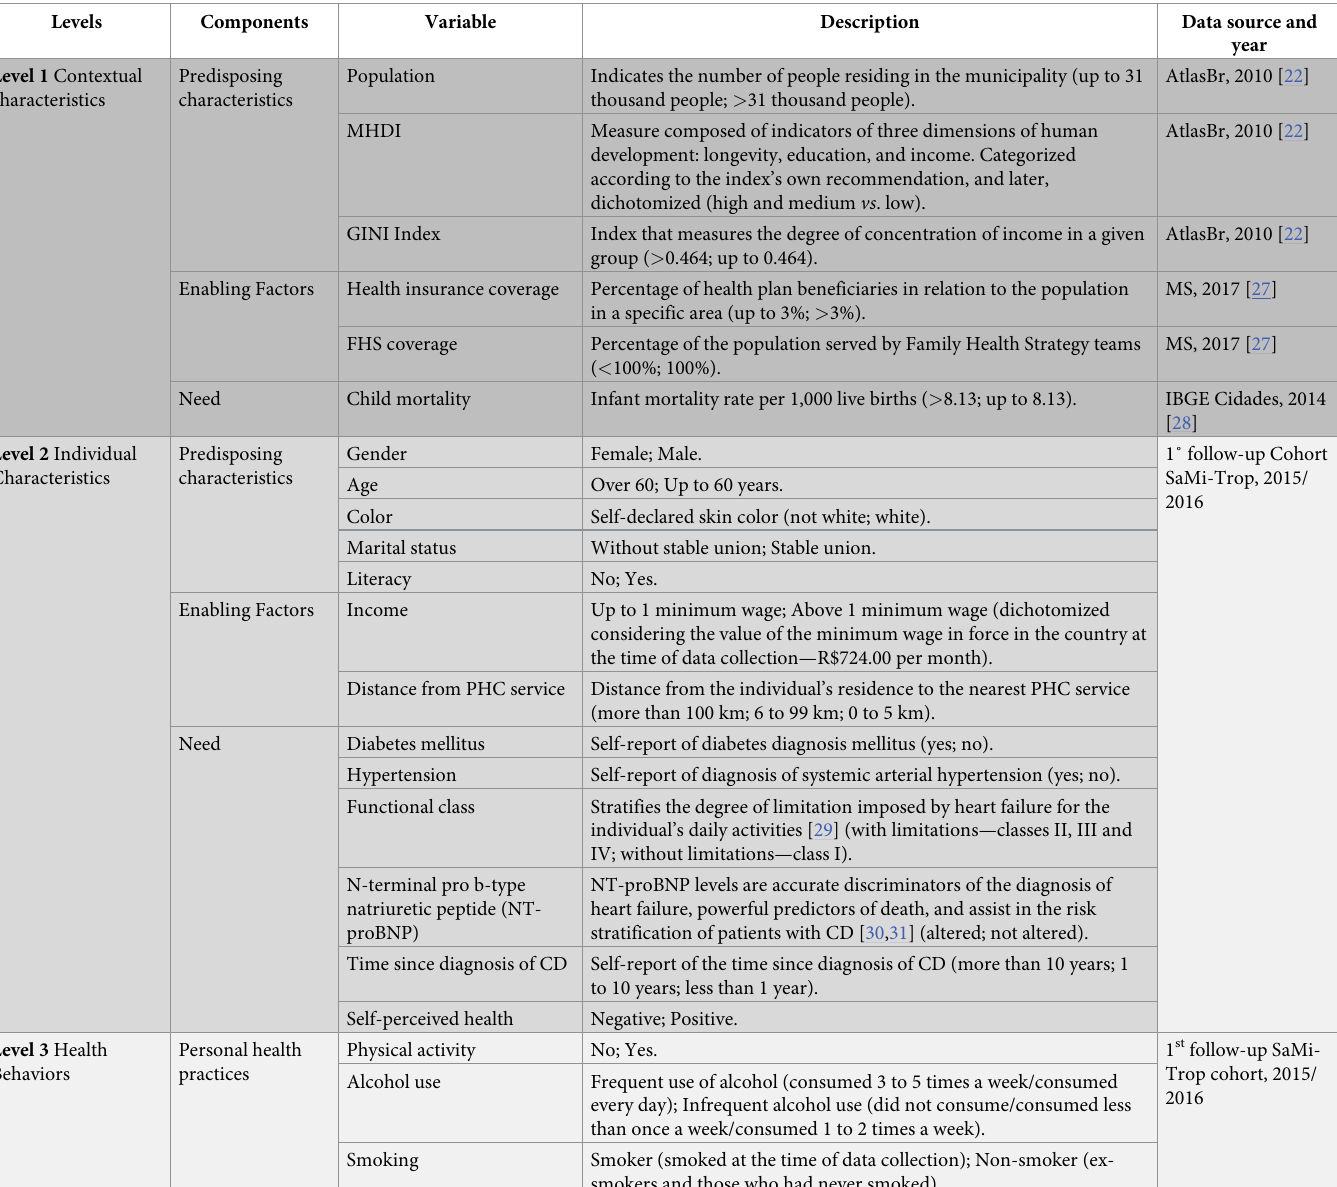
Table 1. Characterization of the study variables based on the levels and components of the Behavioral Models of the Use of Health Services by Andersen &